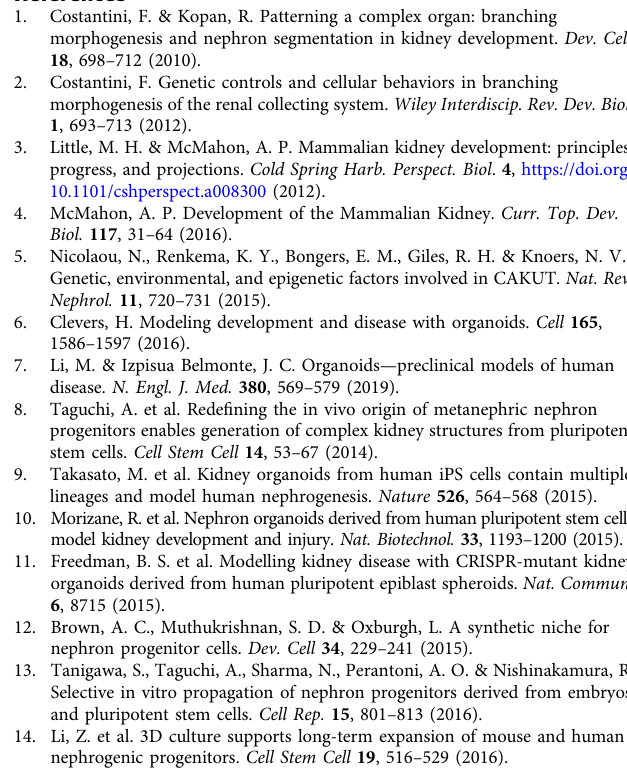
showing similar results. Genetic engineering of hESCs and DNA gel electrophoresis (Supplementary Fig. 4a – e) were performed once. Reporting summary . Further information on research design is available in the Nature Research Reporting Summary linked to this article. Data availability RNA-seq data have been submitted to Gene Expression Omnibus (GEO) with